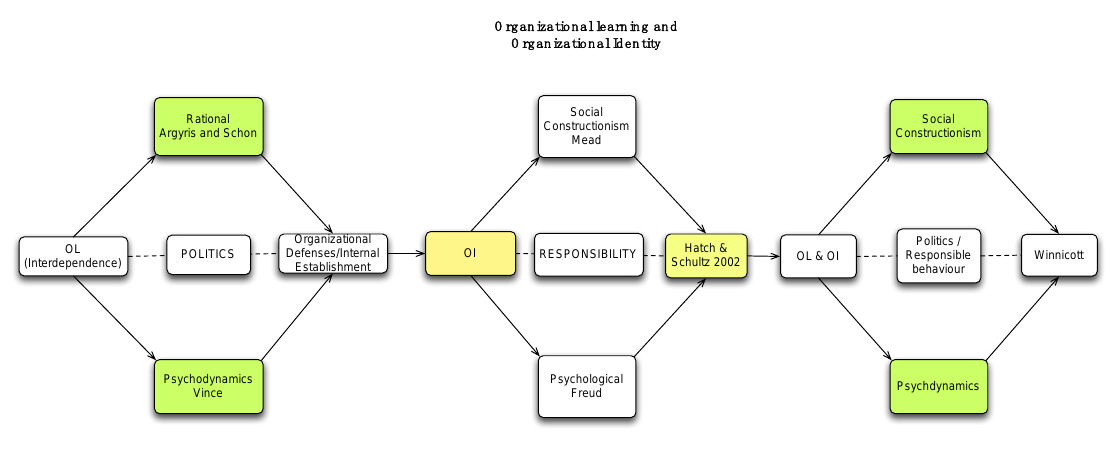
Figure 1. Roadmap of Literature Review.